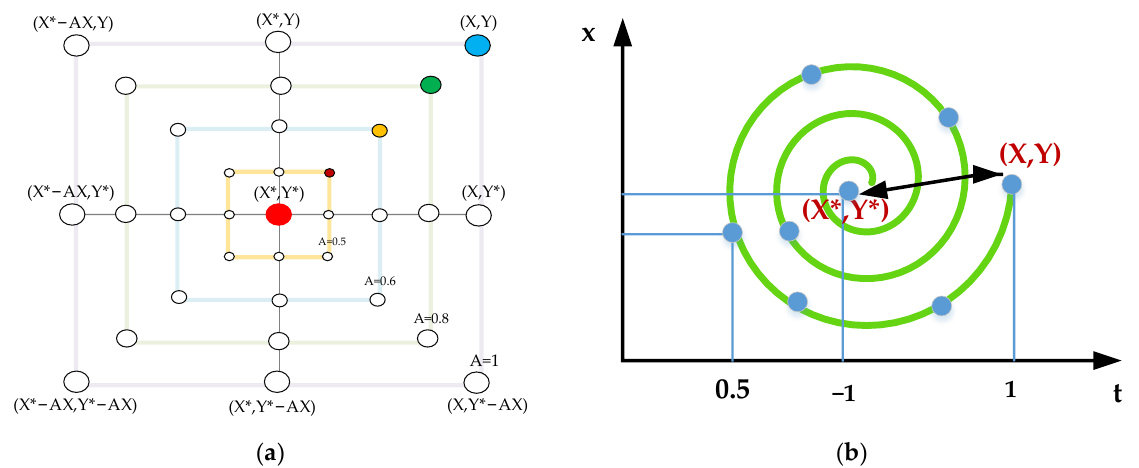
Figure 4. Bubble-net search mechanism implemented in WOA (X * is the best solution obtained so far). ( a ) The shrinking encircling mechanism, and ( b ) spiral updating position.